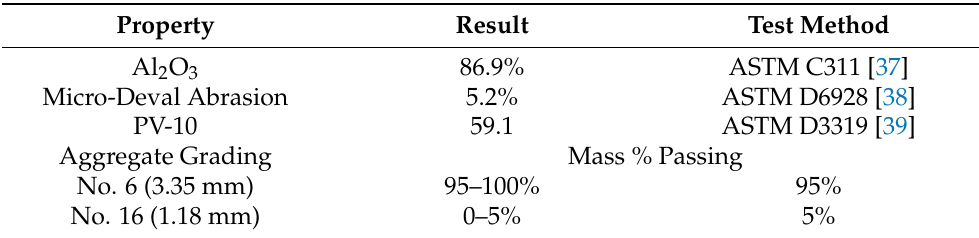
Table 2. Main properties of the calcined bauxite